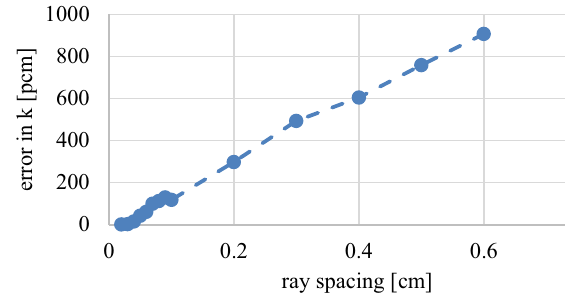
Figure 4. Ganapol convergence with respect to ray spacing